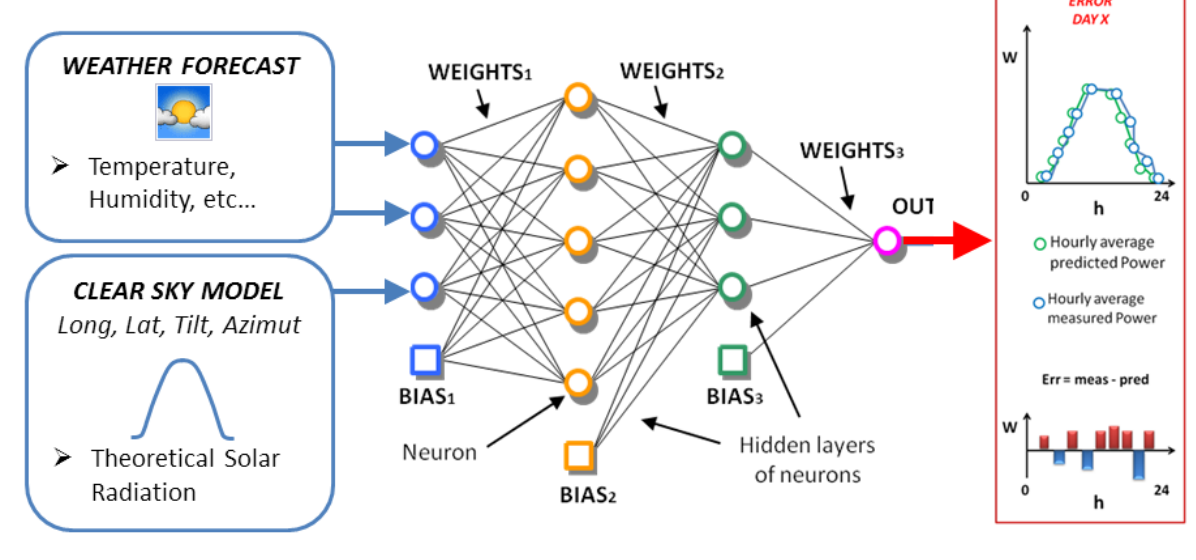
Figure 2. The forecast process used in PHANN